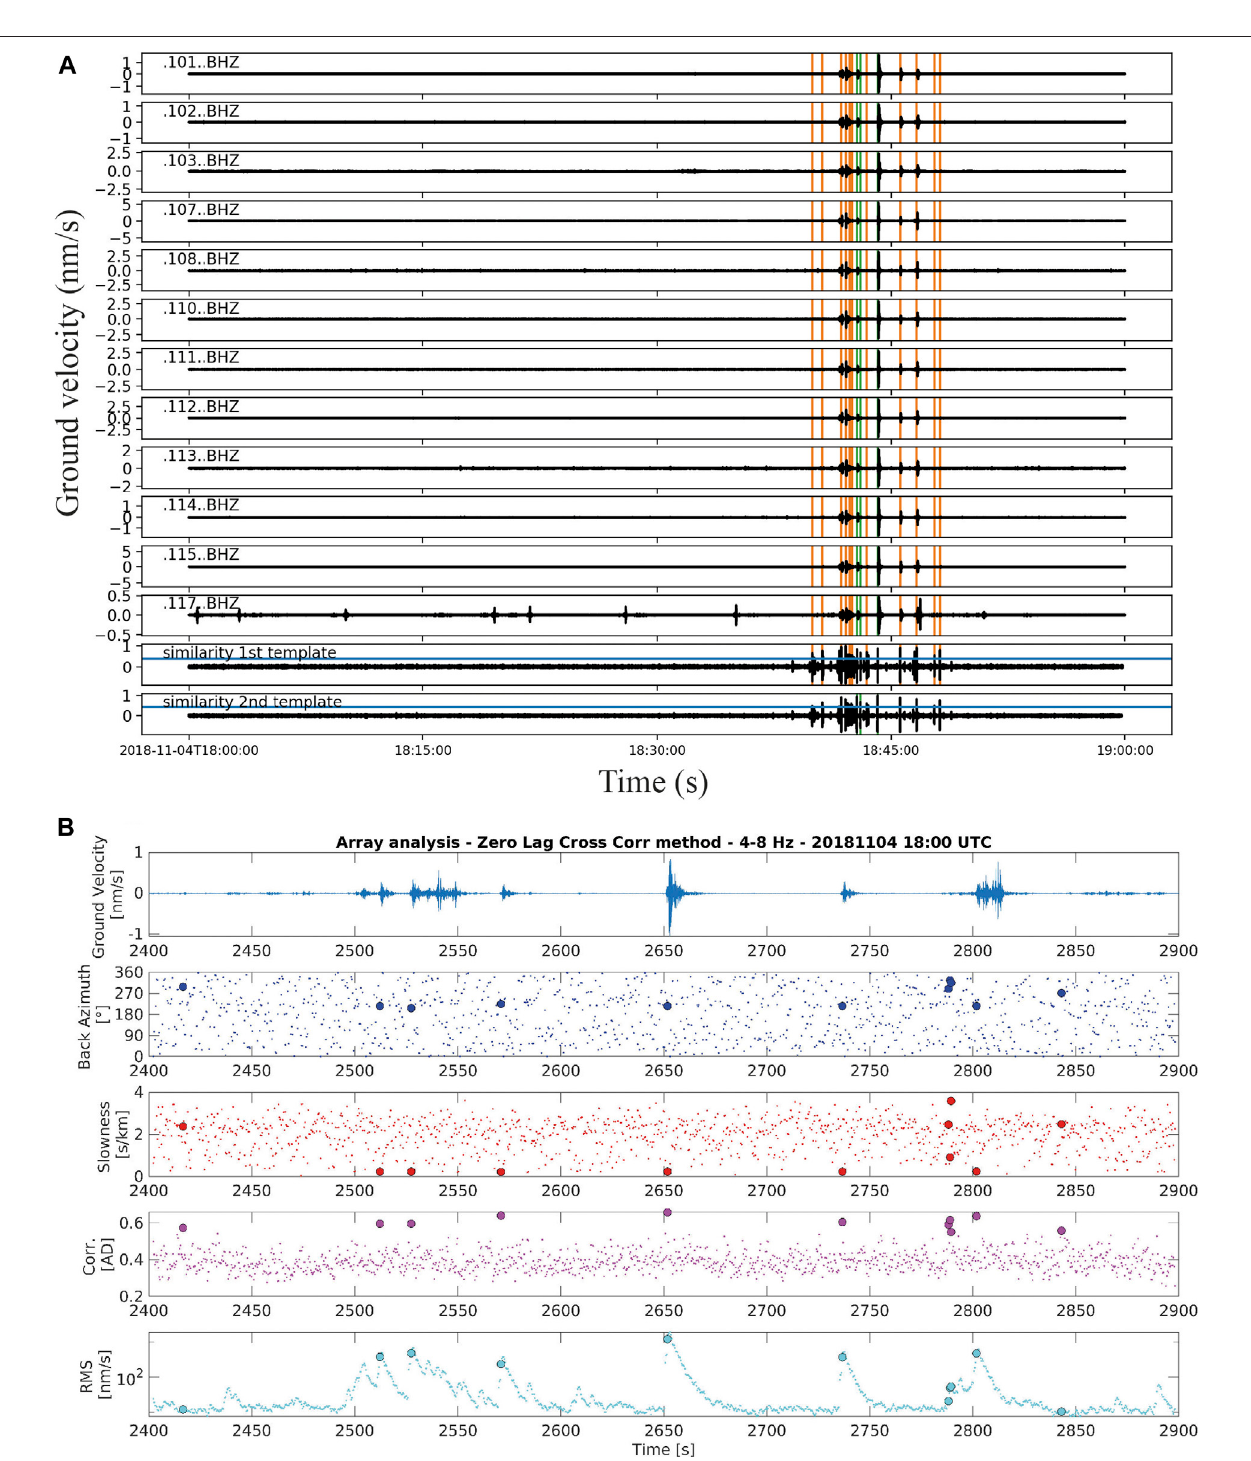
FIGURE8|(A) Exampleofthedetectionalgorithmappliedtoa1-hrecordoftheverticalcomponentofselectedstations.Thestationsarelabeledintheupperleftof each panel. The similarity template plots are also shown. The orange and green vertical lines are the beginning and end, respectively, of the detection window, while the blue horizontal line indicates the detection height. (B) Array analysis of the swarm recorded on 4 November 2018 in the time window 18:40 – 18:48 (top). Back-azimuth, slowness, correlation coef fi cient and RMS of the data are shown. Larger circles show back-azimuth, slowness and RMS of the data relative to correlation coef fi cients larger than